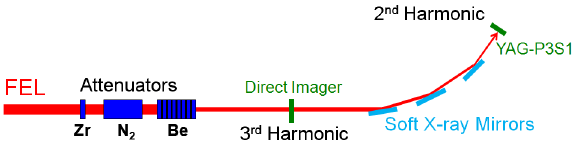
1. Schematic of the harmonic measurements. Attenuators block the fundamental and second harmonic, allowing measure- ment of the third harmonic on the direct imager YAG screen. Alternatively, we can isolate the second harmonic by measuring the intensity at the P3S1 YAG screen; the soft x-ray mirrors, upstream of P3S1, absorb the third harmonic. We again rely on the attenuators to block the fundamental.